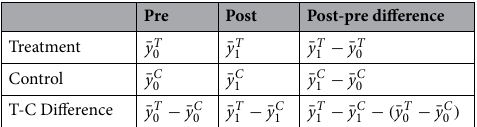
Table 2. Diff-in-diff: difference-in-difference